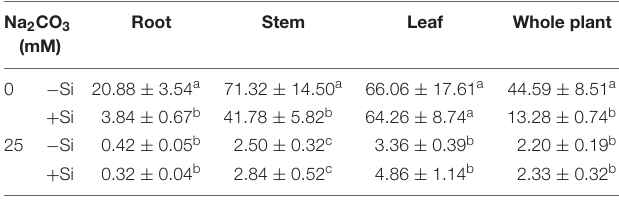
TABLE 3 | Effects of Si priming on the changes of K/Na ratio in alfalfa seedlings under alkaline